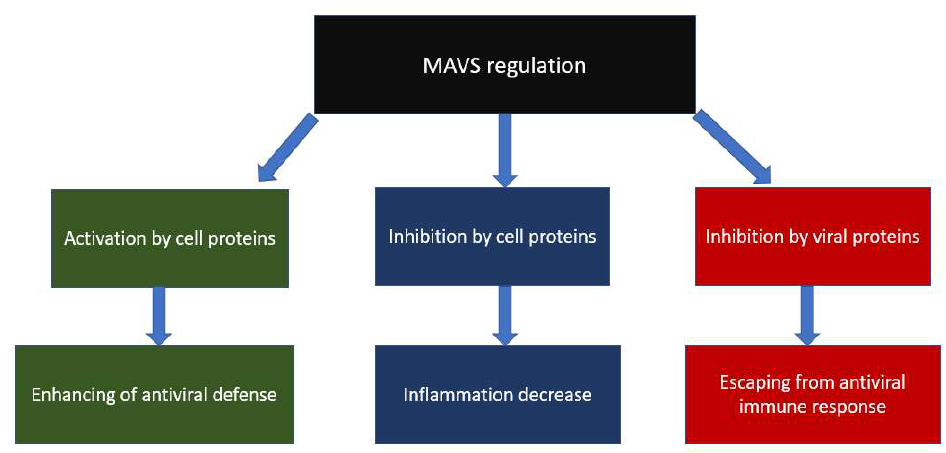
Figure 2. Different MAVS regulation.